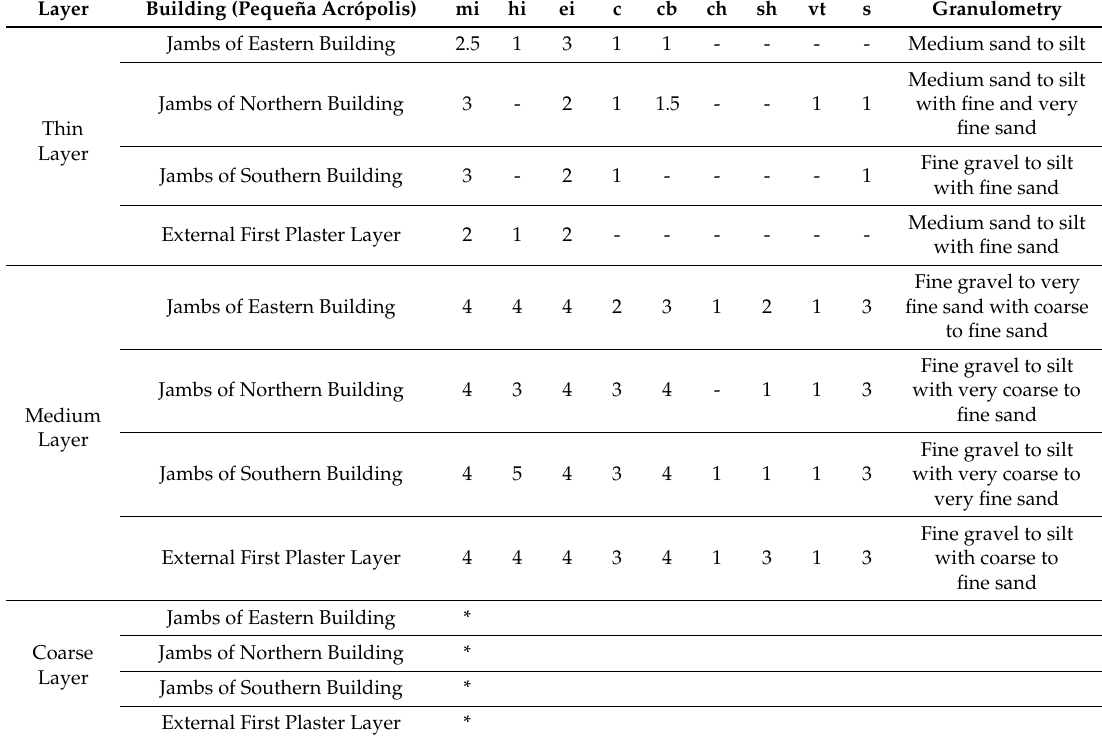
Table 8. Average frequency of inclusions in all the layers of Type 3 plasters. Average frequency of inclusions in all the layers of Type 1 plasters. mi (micritic inclusions); hi (heterogeneous inclusions); si (sparitic inclusions); c (clays); cb (carbon); ch (chert); sh (shells); vt (vegetal tissue); s